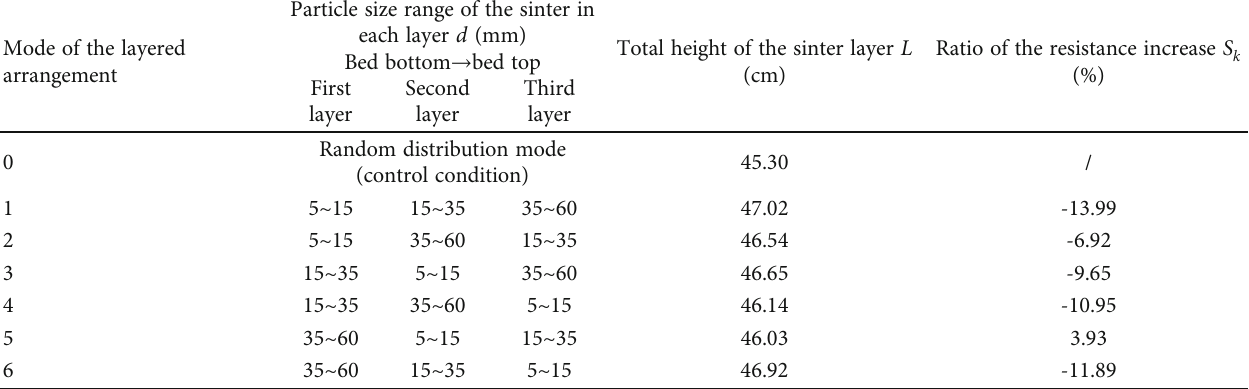
Table 3: All three-layer arrangement modes for the sinter mixture with the equivalent particle diameter of 11.45mm. Mode of the layered